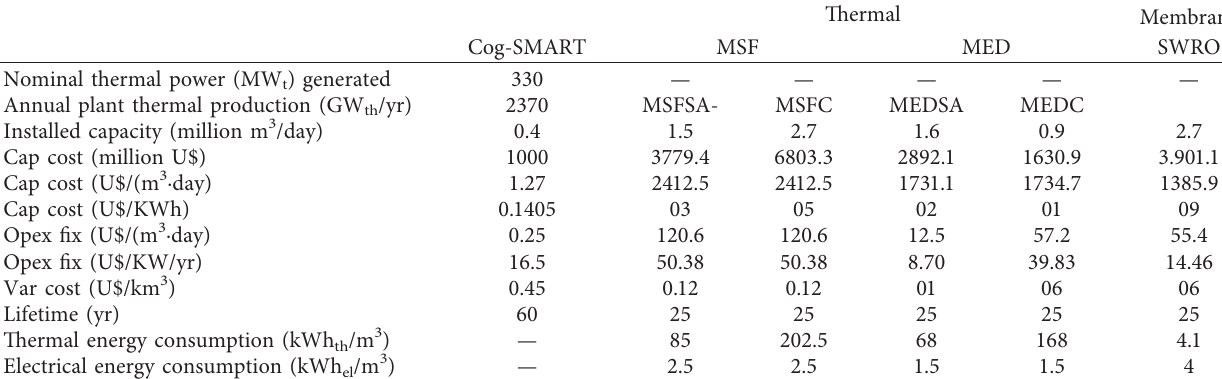
Table 5: The characteristic parameters values of the desalination technologies from [11–16, 74, 78].